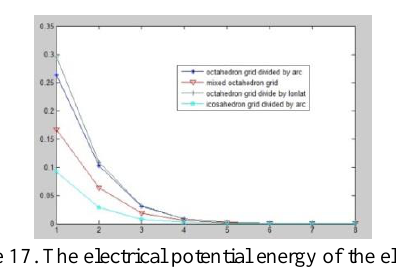
Figure 15. The planar distribution of mean square deviation of major-minor of octahedron grid divided by lonlat